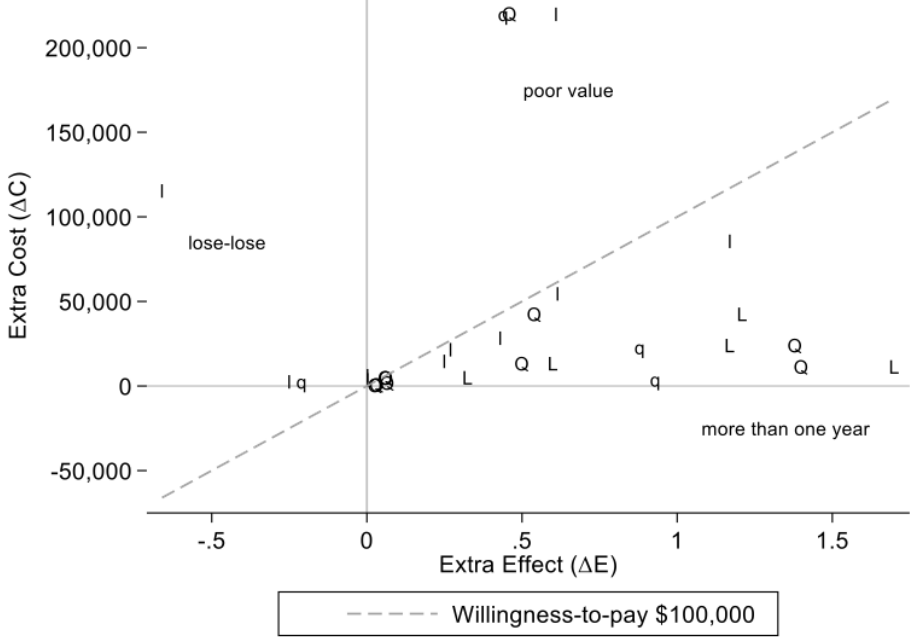
Figure 2. Estimates of Extra Costs and Extra Effects in real world studies of drugs. Q or L indicate QALYs and Life Years estimates of ∆ E from a Model. In contrast, q or l indicate qalys and life years estimates of ∆ E from a person-level analysis (non-Model). Data are only from studies of drugs.